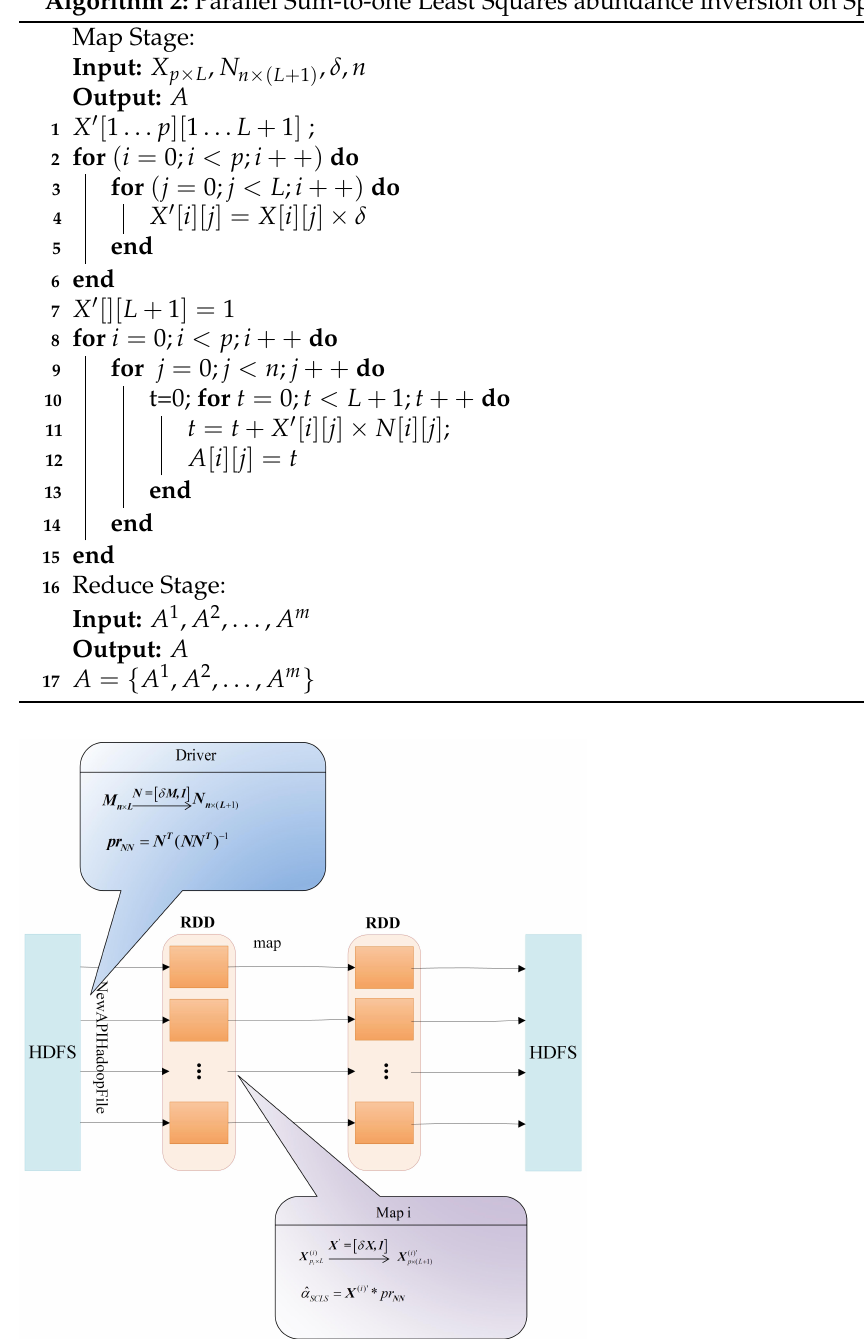
Figure 8. Parallel and distributed implements of sum-to-one constrained least squares